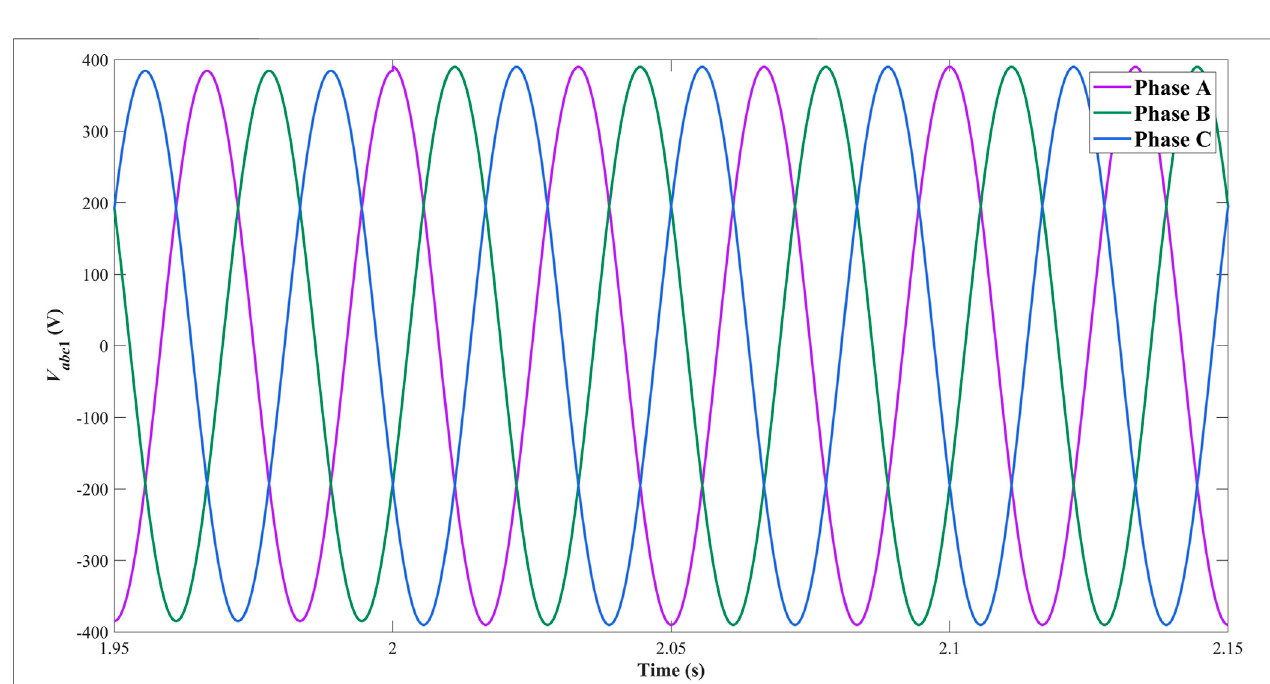
Figure 8 and Figure 9 depict the three-phase waveforms of currents generated from DGus. Figure 10 and Figure 11 depict the three-phase waveforms of voltages of PCCs in subsystem one and subsystem 3. In islanded mode, the decentralized controllers are